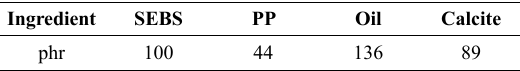
Table 1. Components of basic formulation of compounds (0%